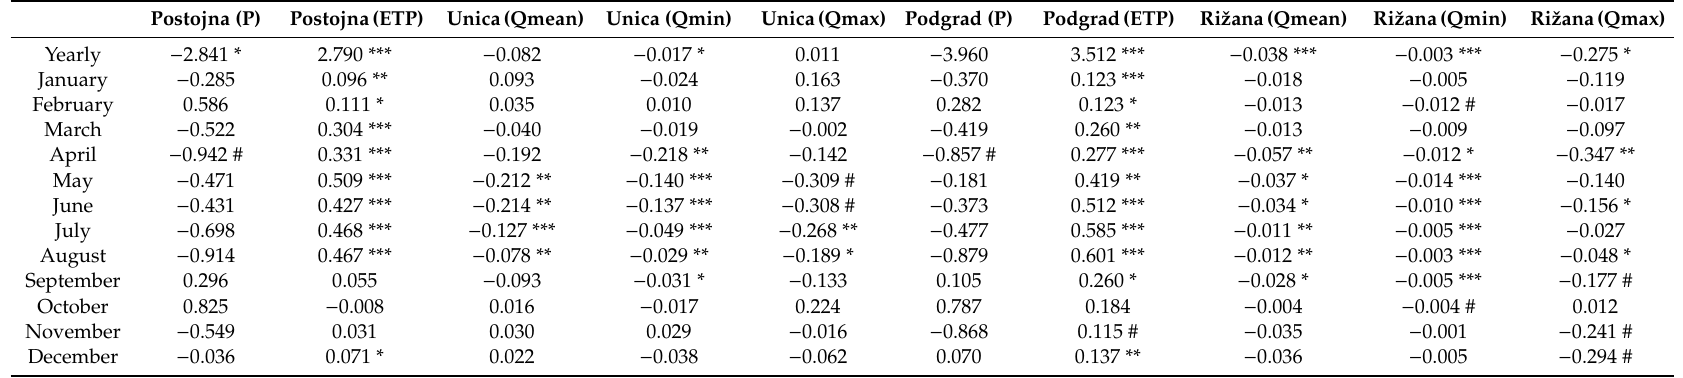
Table 2. Values of Theil-Sen slope estimator ( β ) for selected meteorological and hydrological variables with labelled statistical significance. Units of precipitation (P) and ETP are in mm and of mean (Qmean), minimum (Qmin) and maximum (Qmax) discharge are in m 3 /